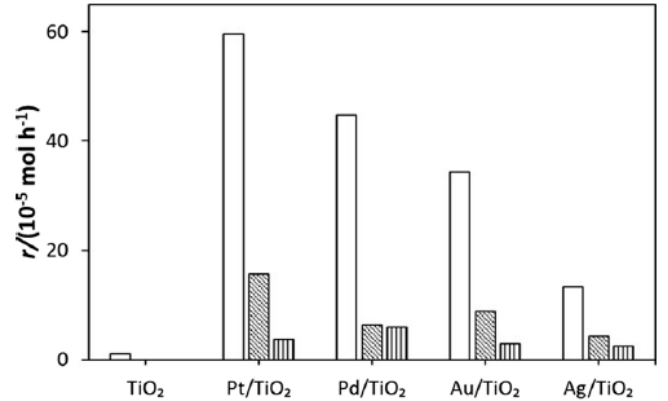
Figure 4. Products of photocatalytic reforming of methanol on different photocatalyst (no shading: H 2 , diagonal shading: CO 2 and vertical shading: CO, adapted from Ref. [42]).